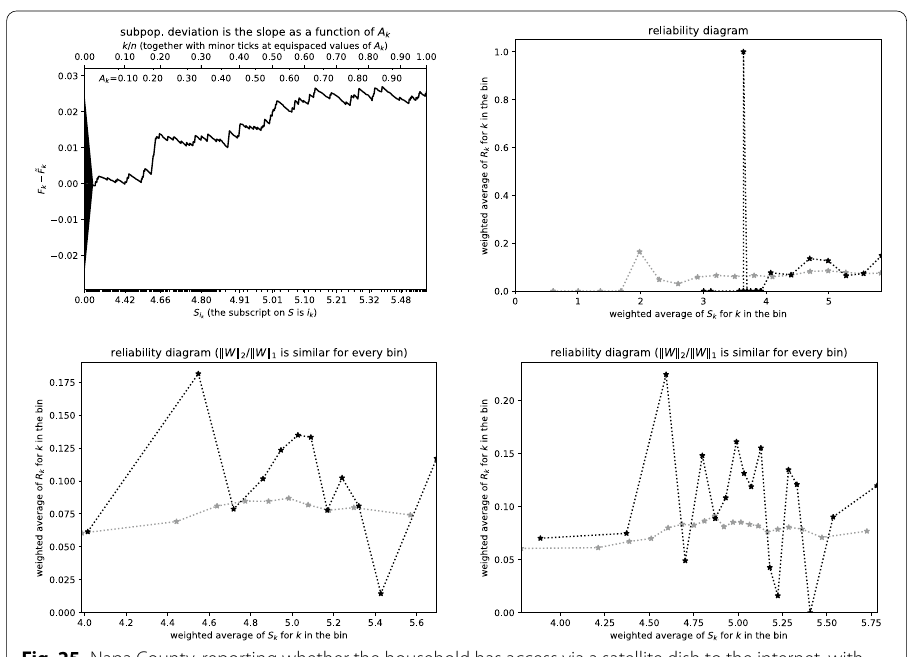
Fig. 25 Napa County, reporting whether the household has access via a satellite dish to the internet, with scores being log 10 of the adjusted household income; n = 679; Kuiper’s statistic is 0.02761 /σ = 2.259 , Kolmogorov’s and Smirnov’s is 0.02695 /σ = 2.205 . The intense deviation around scores of 4.6 is apparent in the reliability diagrams with 10 and 20 bins each, but the latter resolves the spike much better while being unfortunately too noisy for many other scores. The plot of cumulative differences resolves the sharp jump around scores of 4.6 without detracting from the display at other scores. The scalar summary statistics report only very mildly statistically significant deviation, unable to fully account for the high deviation around scores of